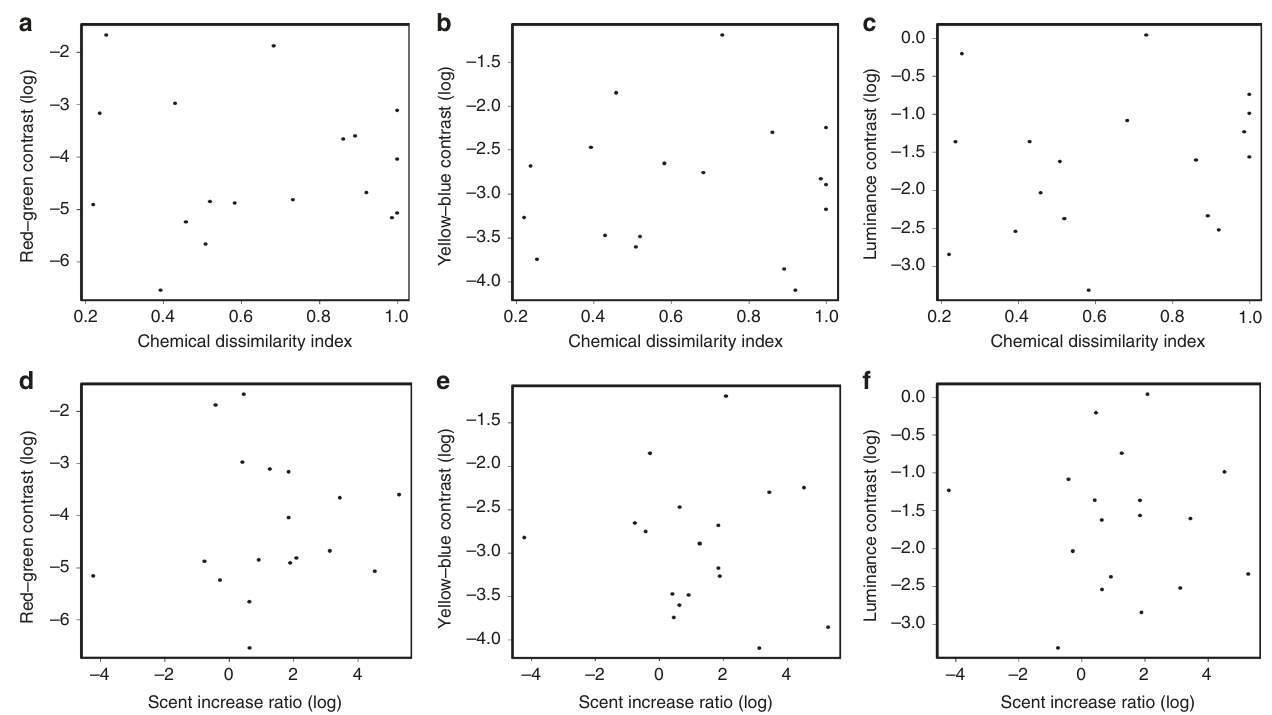
Fig. 4 Correlation between fruit visual and olfactory changes with ripeness. Scatterplots showing three measures of colour distance between unripe and ripe fruits: a red – green contrast, b yellow – blue contrast, c luminance contrast against the Bray – Curtis chemical dissimilarity index, and against the log scent increase ratio ( d – f ). (Pearson ’ s correlation, ripe – unripe chemical dissimilarity: − 0.05, 0.07 and 0.17, respectively; scent increase ratio: 0.07, − 0.1 and − 0.04). Source data are provided as a Source Data fi